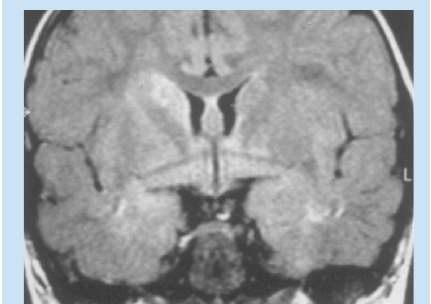
Fig 1c. Coronal FLAIR image showing focal hyper- intensities in the head of the right caudate nucleus and subcortical white matter of the temporal lobes.